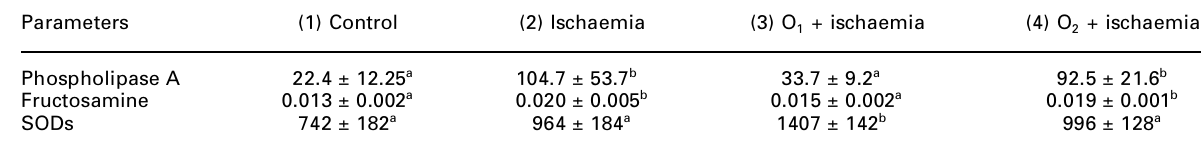
Statistical significance between a and b of at least P <